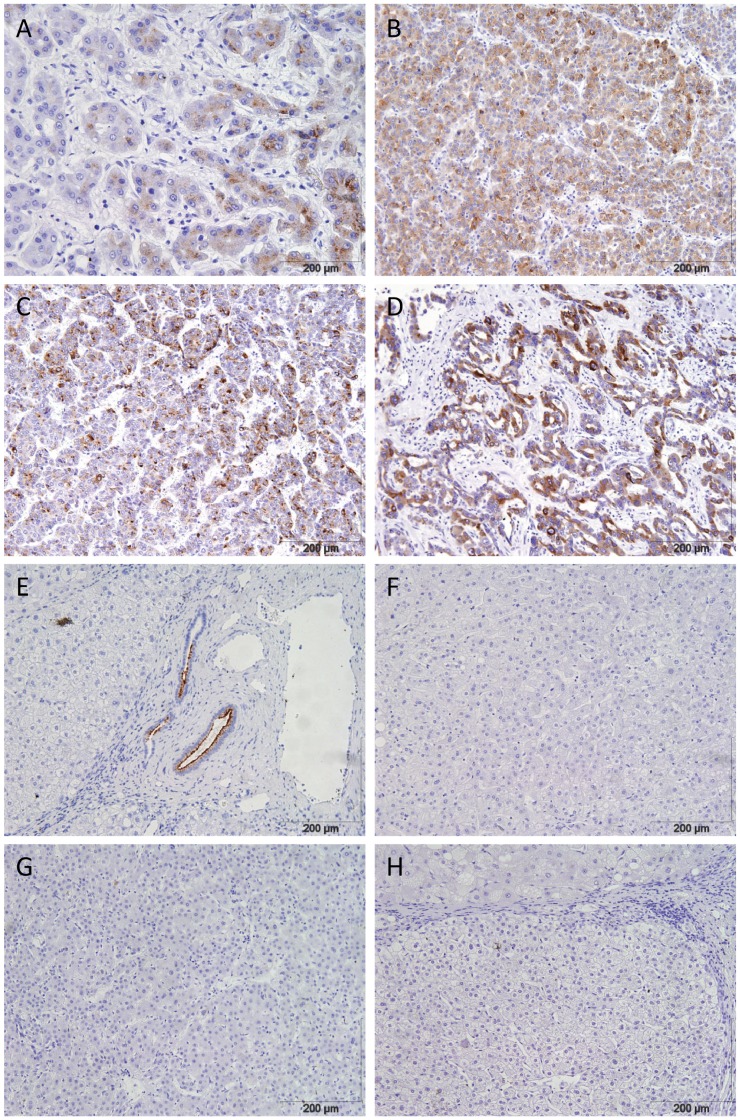
SPINK1 protein is detected in HH-HCC but not benign liver nodules.Immunohistochemistry for SPINK1 in HH liver disease, dysplastic and regenerative nodules and HCC. All images at 10× magnification. A–C) HH-related HCC from patients 1, 2 and 3. D) Mixed cholangiocellular carcinoma and HCC from patient 1. E) Background HH cirrhosis, showing positive SPINK1 expression in a large bile duct. F) Regenerative nodule. G) Dysplastic nodule. H) Diffuse small cell dysplasia.